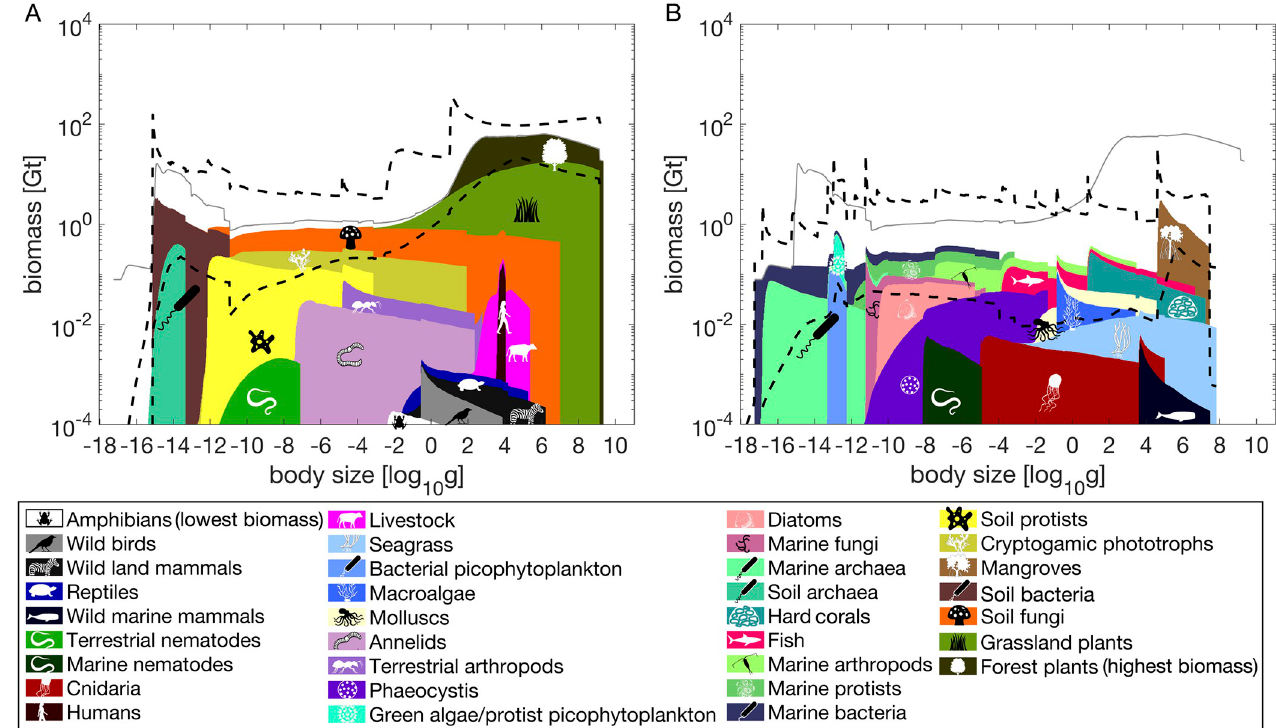
Fig 3. Body size biomass spectra by habitat realms. See Fig 1 caption for description. A. Terrestrial. B. Marine. Subterranean prokaryotes are excluded. Thin grey curves are the median cumulative log biomass of the global biome.